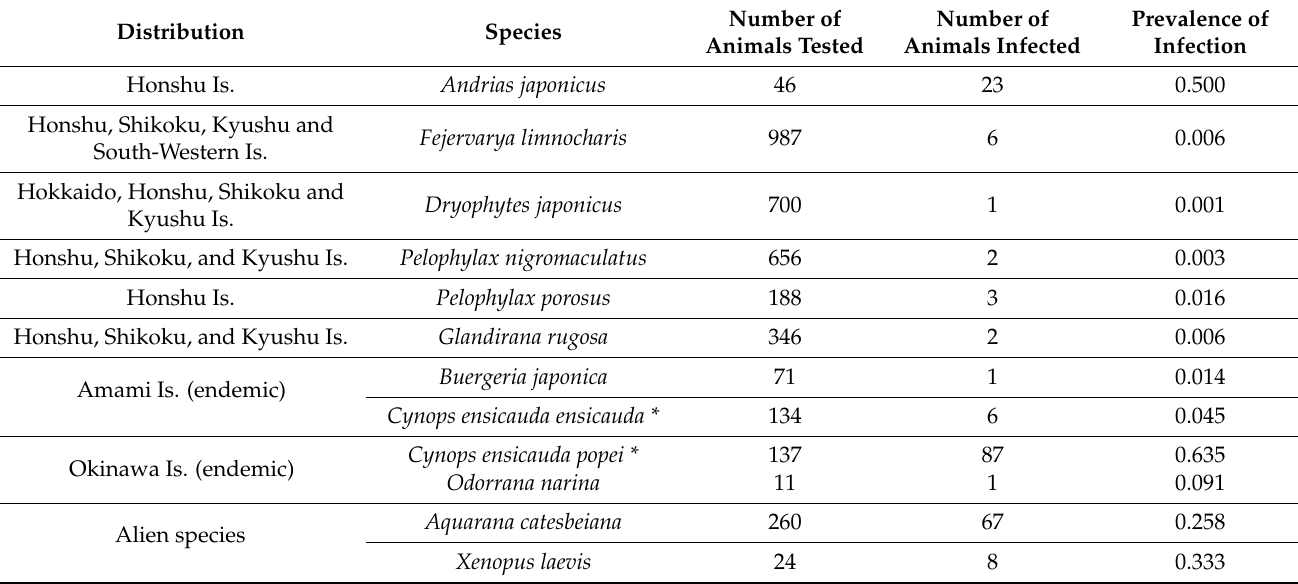
Table 1. Prevalence of Bd infection in amphibian species in